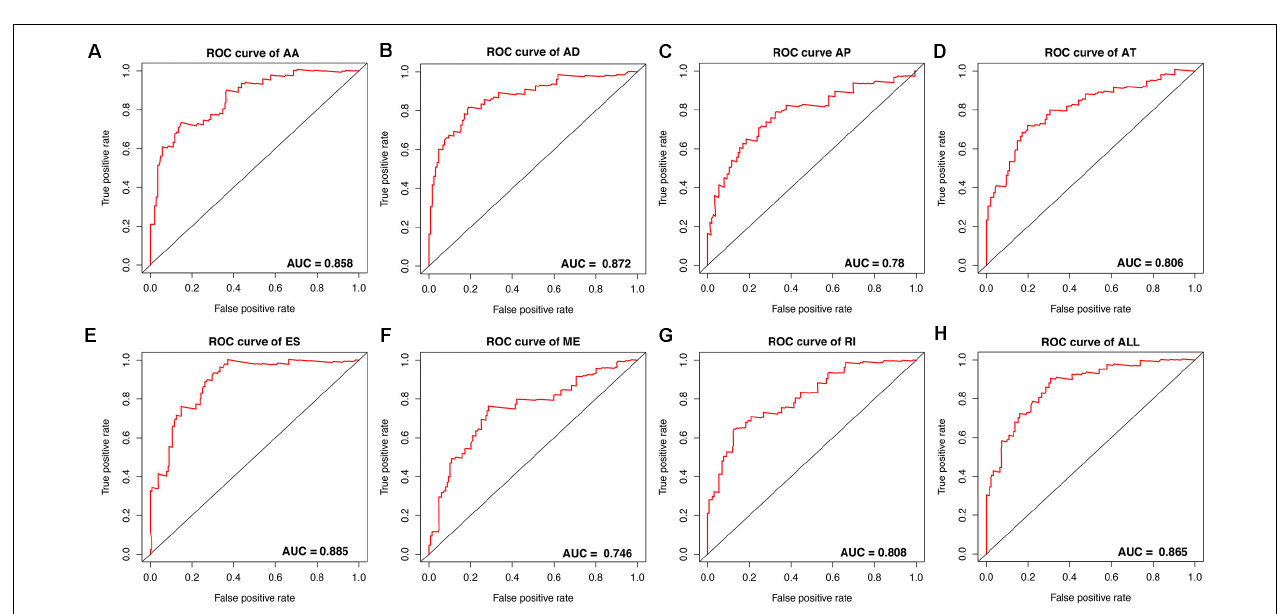
FIGURE 5 | Kaplan-Meier curve of prognostic predictors constructed with either one type or all seven AS types in the ESCA cohort. (A) AA: alternate acceptor site. (B) AD: alternate donor site. (C) AP: alternate promoter. (D) AT: alternate terminator. (E) ES: exon skip. (F) ME: mutually exclusive exons. (G) RI: retained intron. (H) ALL: all seven AS types combined. Red line indicates high-risk subgroup while blue line indicates low-risk subgroup.